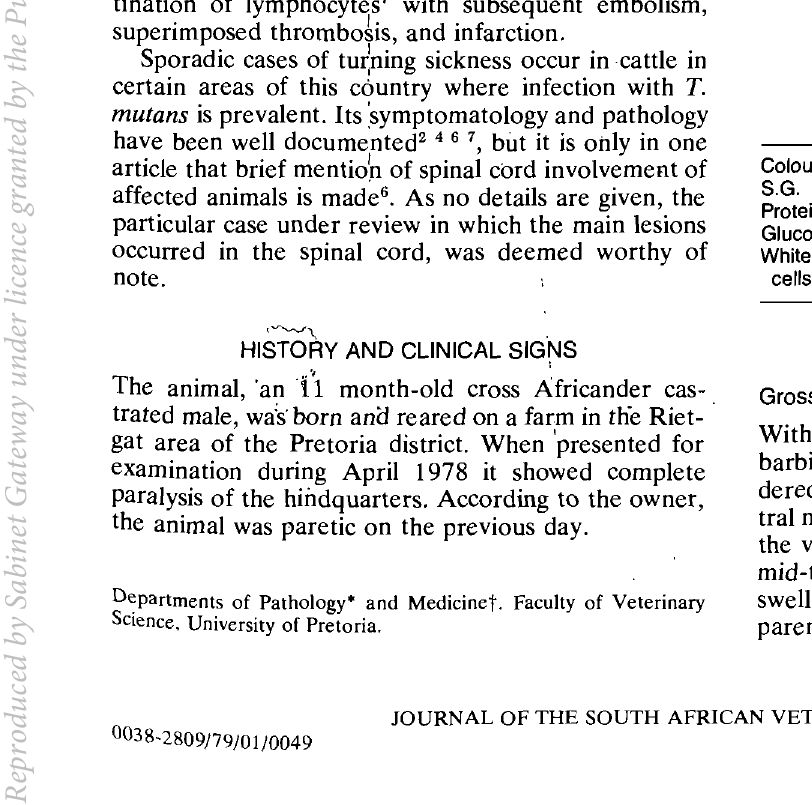
Table 1: COMPOSITION OF CEREBROSPINAL FLUID COM PARED TO NORMAL BOVINE VALUES AND THOSE IN OTHER CASES OF TURNING